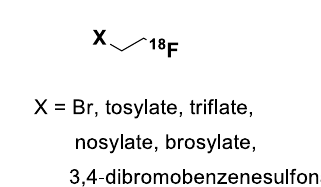
Fig. 1 Short chain (n 2) 18 Flabeled aliphatic building blocks (Born et al. 2017): [ 18 F]Fluoromethyl ≤ bromide/ iodide/ tosylate, [ 18 F]Fluoroethyl bromide/ tosylate/ triflate/ nosylate/ brosylate/ -3,4-dibromobenzenesulfonate, and [ 18